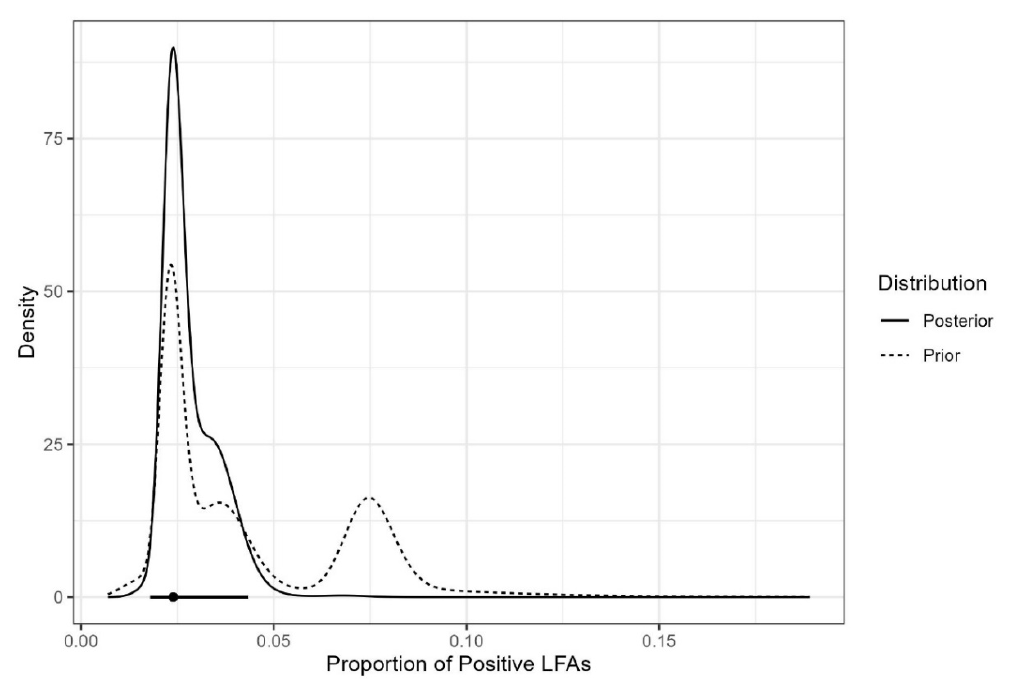
Figure 2. Prior and posterior densities of the proportion of positive LFAs with estimated prevalence and HPD credible interval.